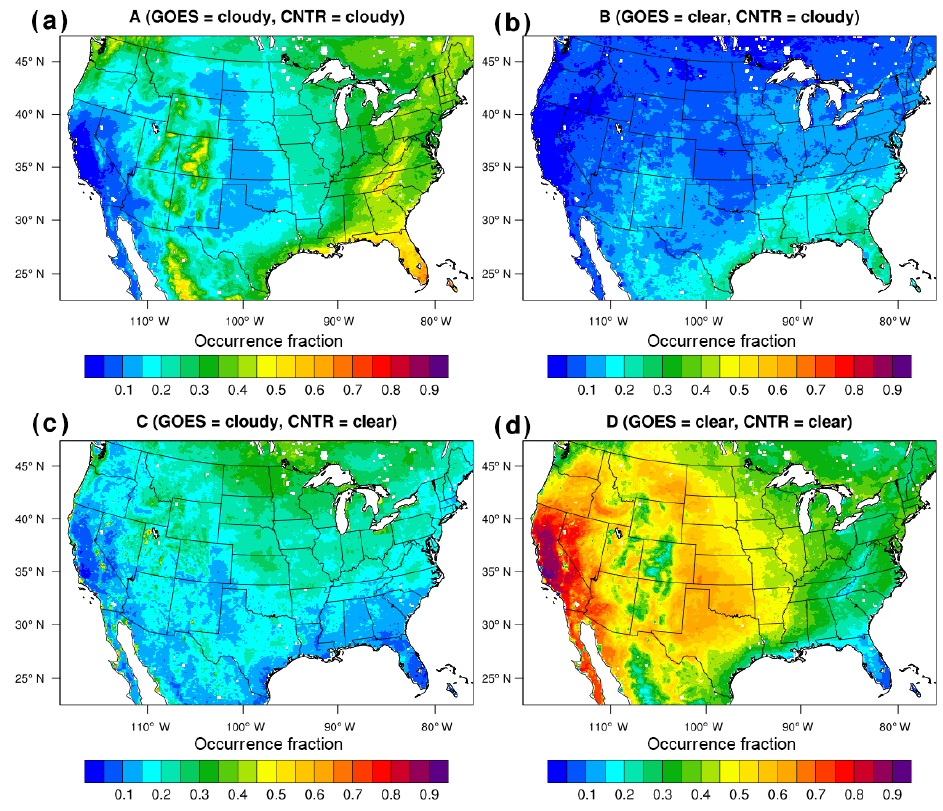
Figure 1. Spatial distribution of each contingency category (see Table 2) between the WRF-generated clouds (CNTR simulation) and Sat- CORPS GOES retrievals averaged over the whole study